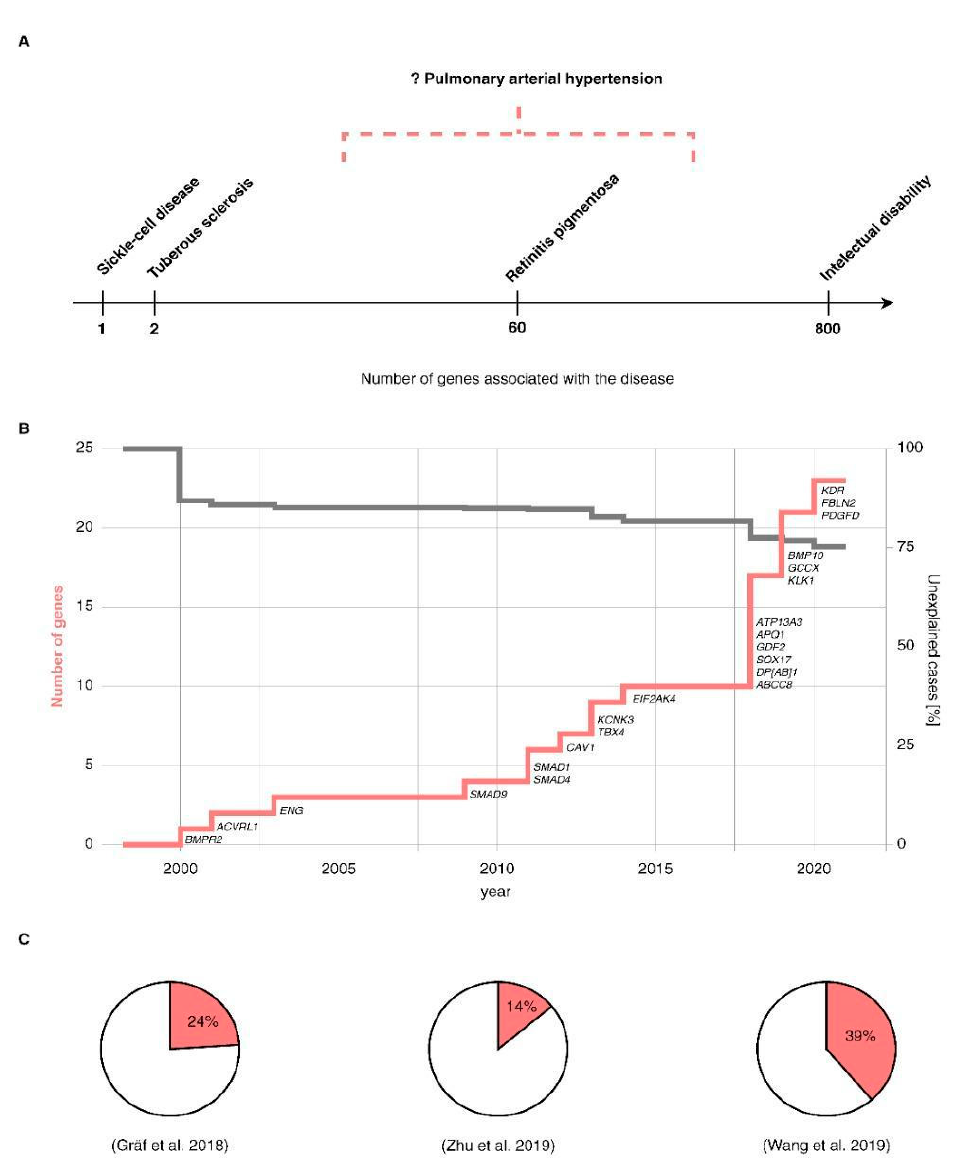
Figure 3. ( A ). Genetic heterogeneity in various genetic disorders, ( B ). Genetic discoveries in PAH, ( C